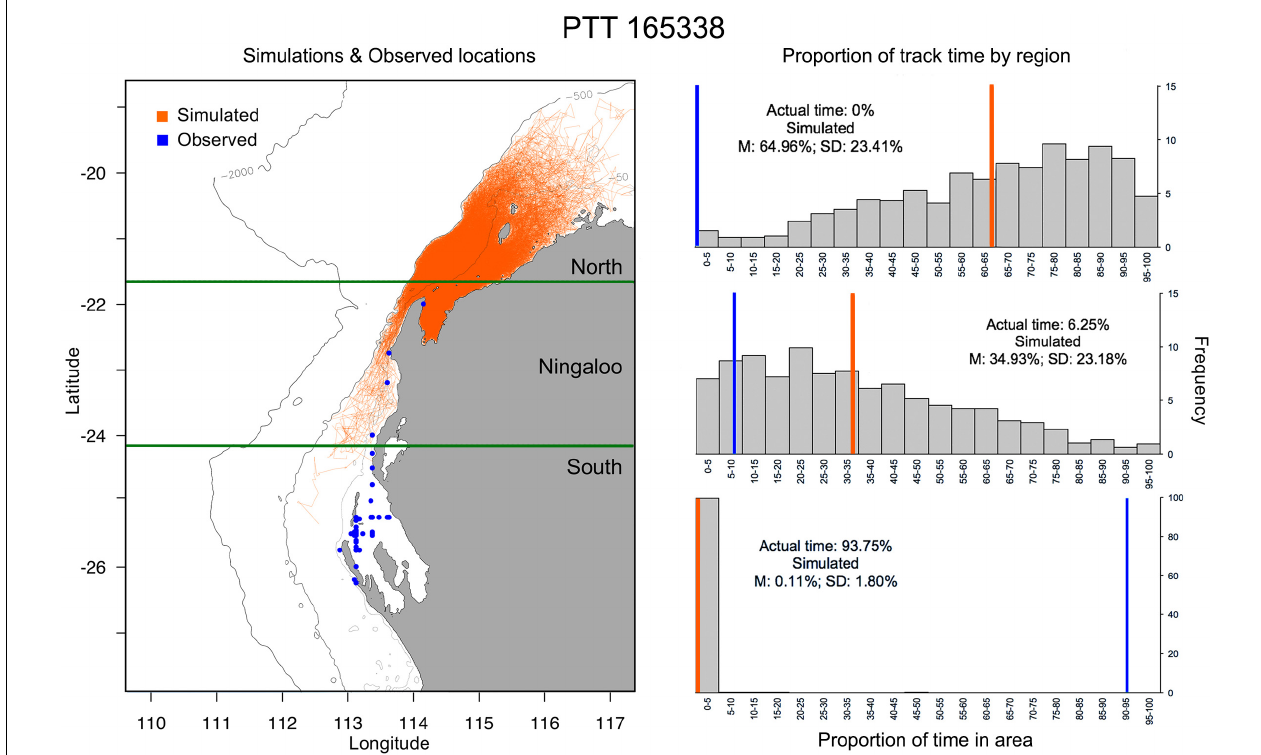
FIGURE 6 | Example of simulated tracks ( left panel ; n = 1000) based on Tag 165338 deployment duration vs modelled track (blue) and (right panel) the proportion of time (grey bars) and mean time (orange line) simulated tracks occupy latitudes to the north of Ningaloo Marine Park (top), encompassing Ningaloo Marine Park (middle) or south of Ningaloo marine park (bottom) vs. area occupation by the observed track (blue line). Depth contours indicate 500 m (innermost) and 2000 m (outermost), while the open white circle indicates the starting location for track